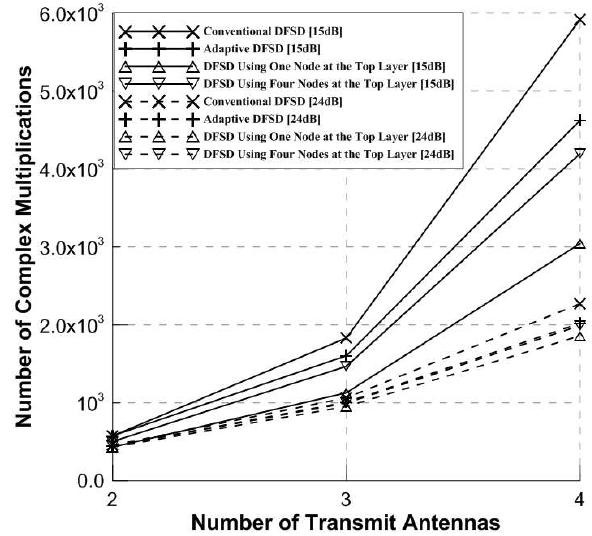
Figure 13. The complexity of the detection schemes according to number of transmit antennas with 16-QAM.